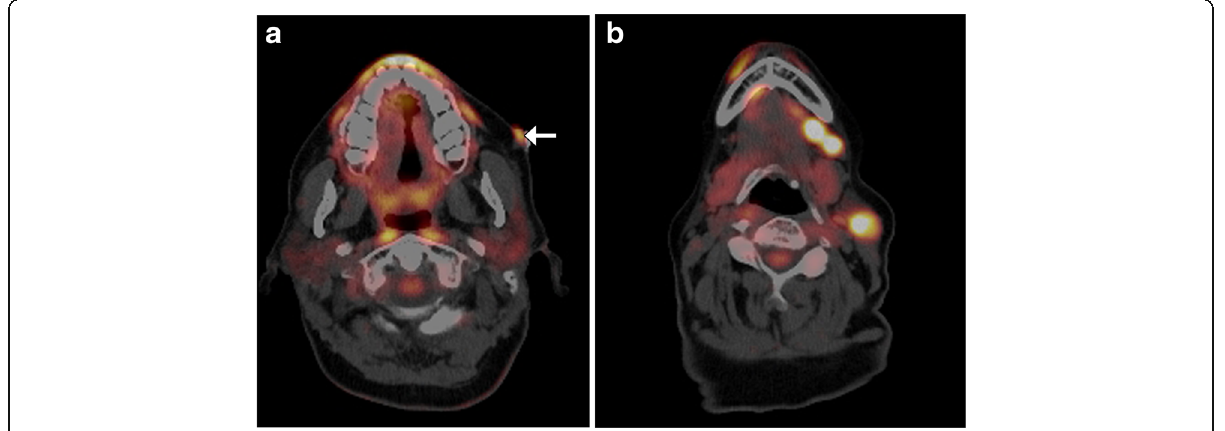
Fig. 13 Merkel cell carcinoma. Axial fused 18 FDG-PET/CT images ( a and b ) show a hypermetabolic left cheek lesion (arrow) and ipsilateral suprahyoid metastatic lymphadenopathy